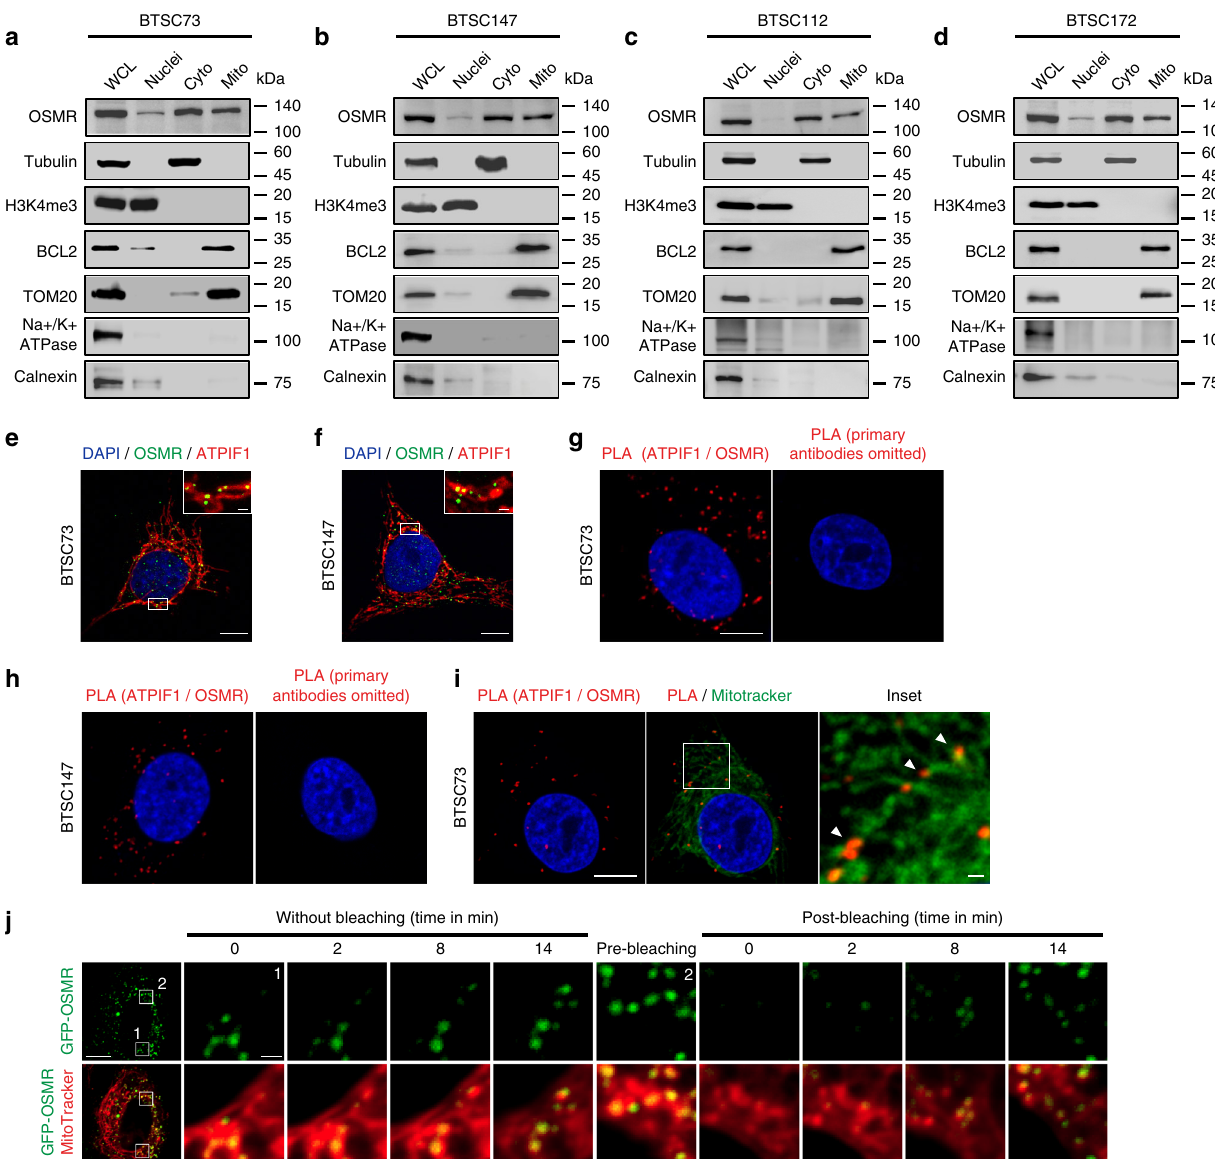
Fig. 1 Presence of mitochondrial OSMR in human BTSCs. a – d Four different patient-derived BTSC lines were subjected to subcellular fractionation, and the lysates for each fraction were analyzed by immunoblotting using antibodies to OSMR. α -Tubulin, H3K4me3, BCL2/TOM20, Na + /K + ATPase, and calnexin. WCL: Whole-cell lysates; Cyto: cytoplasmic; Mito: mitochondrial. The Western blots represent a minimum of three replicates from different passage numbers for each BTSC. e , f BTSC73 and BTSC147 were subjected to immunostaining using antibodies to OSMR (green) and the mitochondrial matrix protein ATP synthase inhibitor F1 (ATPIF1, red). Nuclei were stained with DAPI. White rectangles mark the inset to demonstrate the co-localization of OSMR with ATPIF1. g , h PLA of OSMR and ATPIF1 were performed in BTSC73 ( g ) and BTSC147 ( h ). Primary antibodies were omitted as controls. i Double labeling of the PLA signal (red) and the MitoTracker (green) in BTSC73 is shown. j A FRAP assay was performed on BTSC73 transduced with GFP-OSMR and stained with MitoTracker (red). Different regions of interest (ROIs) containing GFP-OSMR in the mitochondria were de fi ned. ROI1 indicates a non-bleached area and ROI2, a photobleached area. The fl uorescence recovery was monitored over time following photobleaching. Images were obtained on a laser scanning confocal microscope (ZEISS LSM 800). Scale bar = 10 μ m; Inset scale bar = 1 μ m. Representative images of three independent experiments are